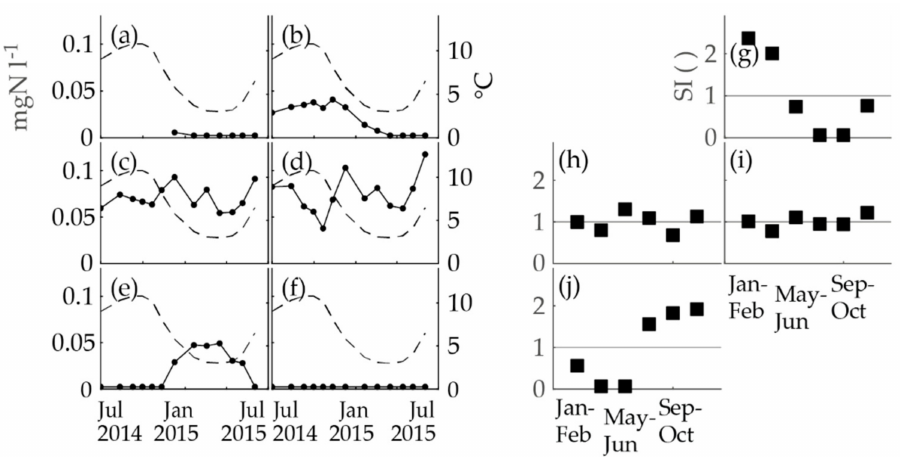
Figure 5. The nitrite concentrations (the black dots and an unbroken line; the left y -axis) compared to the temperature (the dashed line; the right y -axis) at the WTP and the two-month seasonal indices of nitrite concentrations (the black squares, N of nitrite analyses for each box = 2–3) of the sampling campaign. The parts of the figure are as follows: ( a ) nitrite at Pitkäkoski WTP (Process Line 1), ( b ) nitrite at Pitkäkoski WTP (a tap in the on-site laboratory), ( c ) nitrite at Sport Center M, ( d ) nitrite at Gas Station R, ( e ) nitrite at Gas Station K, ( f ) nitrite at Hospital K, ( g ) seasonal indices of nitrite at Pitkäkoski WTP (a tap in the on-site laboratory), ( h ) seasonal indices of nitrite at Sport Center M, ( i ) seasonal indices of nitrite at Gas Station R, and ( j ) seasonal indices of nitrite at Gas Station